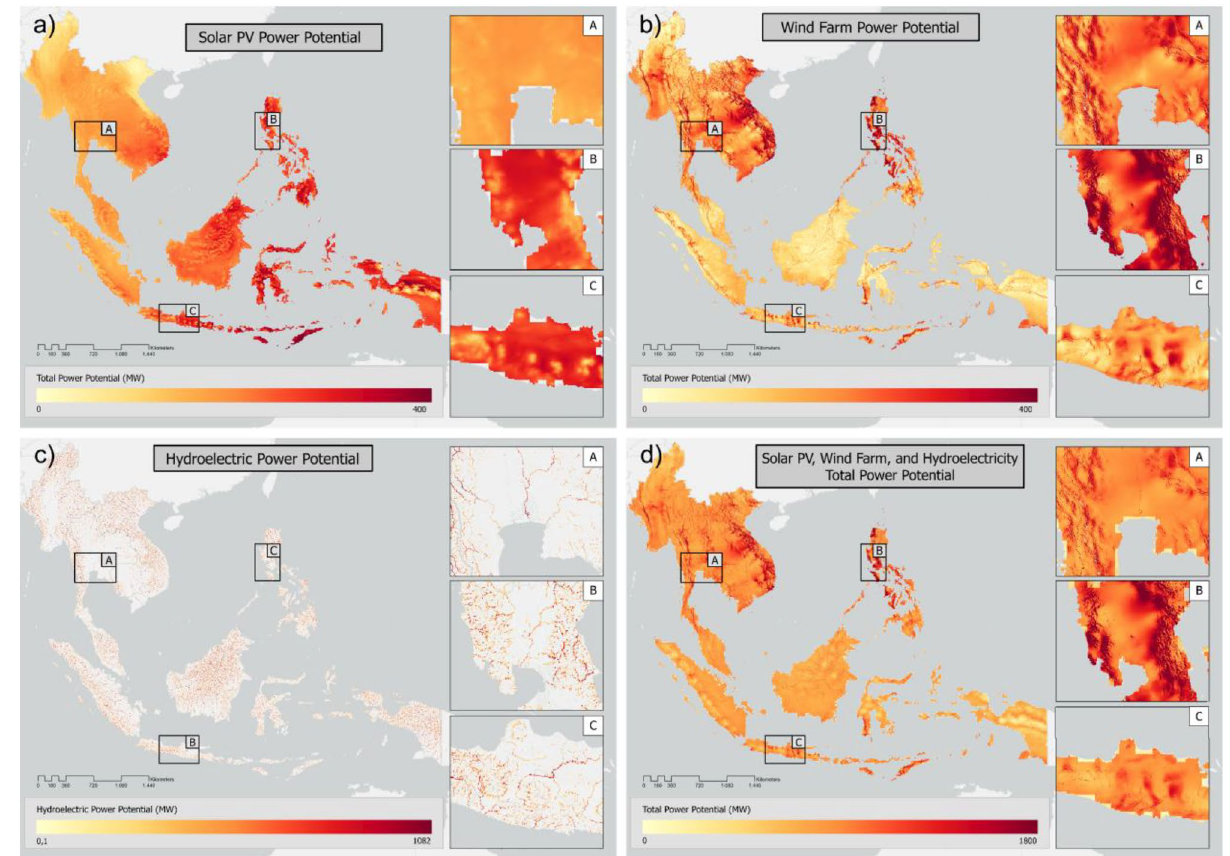
Figure 6. Power potential for ( a ) solar photovoltaic (PV), ( b ) wind, and ( c ) hydroelectric power, as well as the ( d ) total combination of the three types of